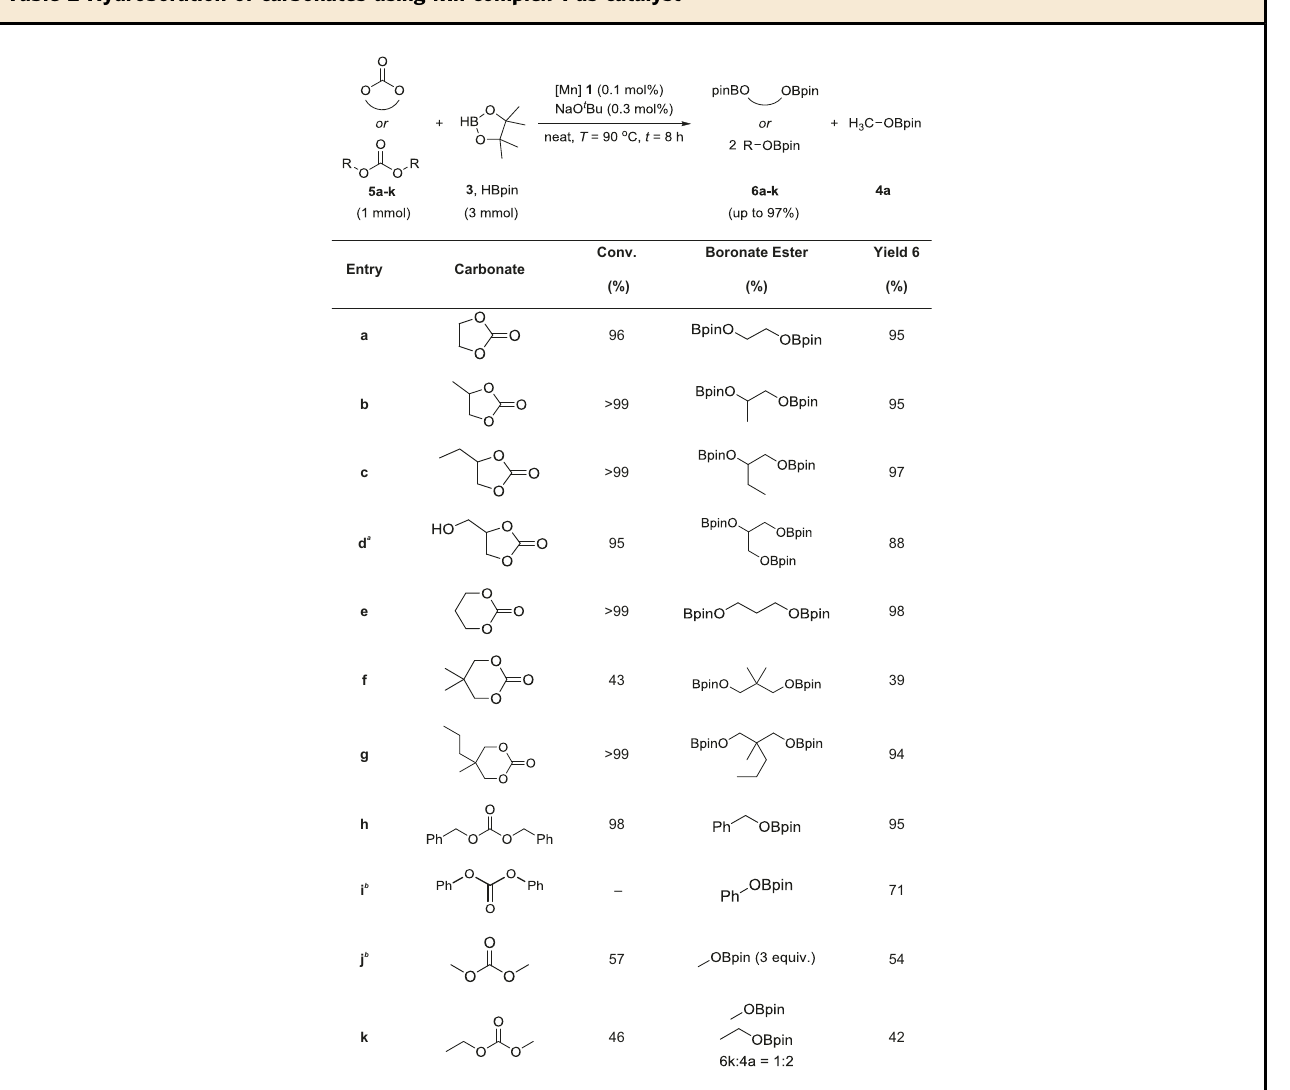
Table 2 Hydroboration of carbonates using Mn complex 1 as